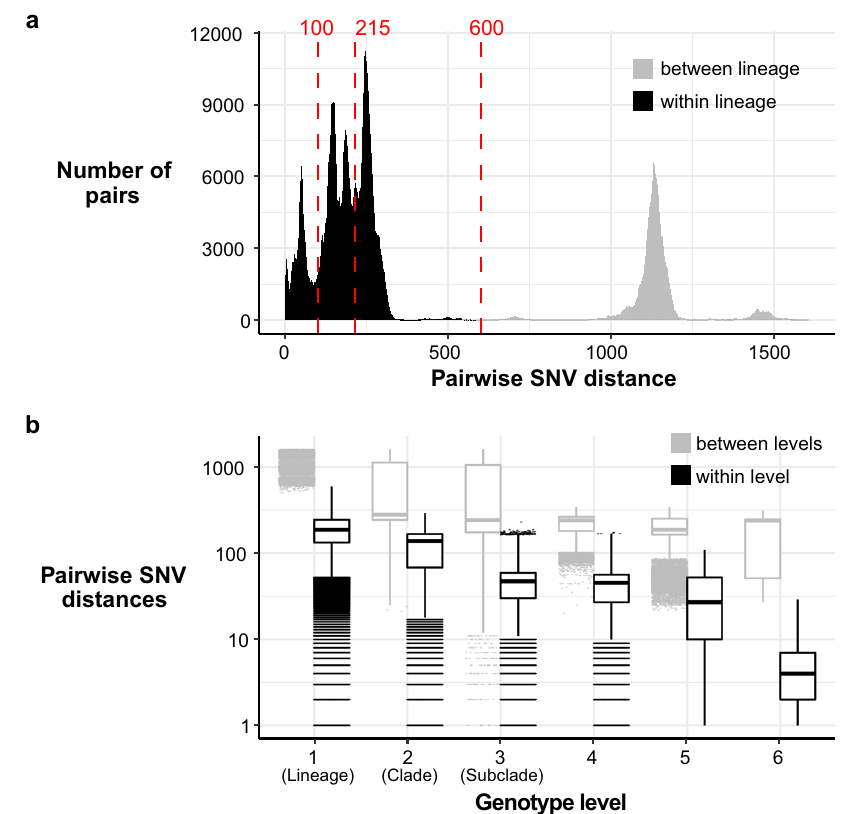
Fig. 2 Distribution of SNV distances in discovery genomes. a Histogram of pairwise SNV distances between all discovery genomes, coloured by lineage comparison as per legend. Red lines mark SNV cut-offs used to de fi ne lineage, clade and subclade levels in genotyping scheme. b Boxplots of pairwise SNV distances (log scale, n = 1,873,081 pairwise distances) between discovery genomes at different hierarchical levels of the de fi ned genotyping scheme. Boxes indicate the median (bold line), 25th to 75th percentiles (box), and the 5th and 95th percentile (whiskers), with outliers shown as points. Lineage, Clade and Subclade refer to the fi rst three levels of the scheme. ‘ 4 ’ indicates the fourth level of the scheme (i.e., the fi nal ‘ 1 ’ in 3.6.1.1), ‘ 5 ’ the fi fth level (i.e., the ‘ 1 ’ in 3.7.30.4.1), and ‘ 6 ’ the sixth level (i.e., the fi nal ‘ 1 ’ in